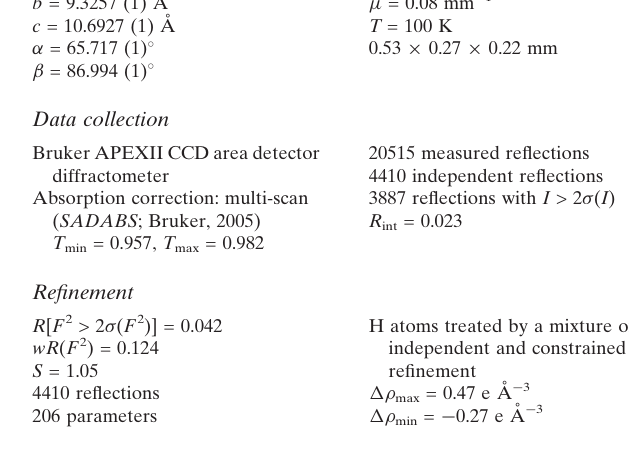
Data collection Bruker APEXII CCD area detector diffractometer Absorption correction: multi-scan ( SADABS ; Bruker, 2005)